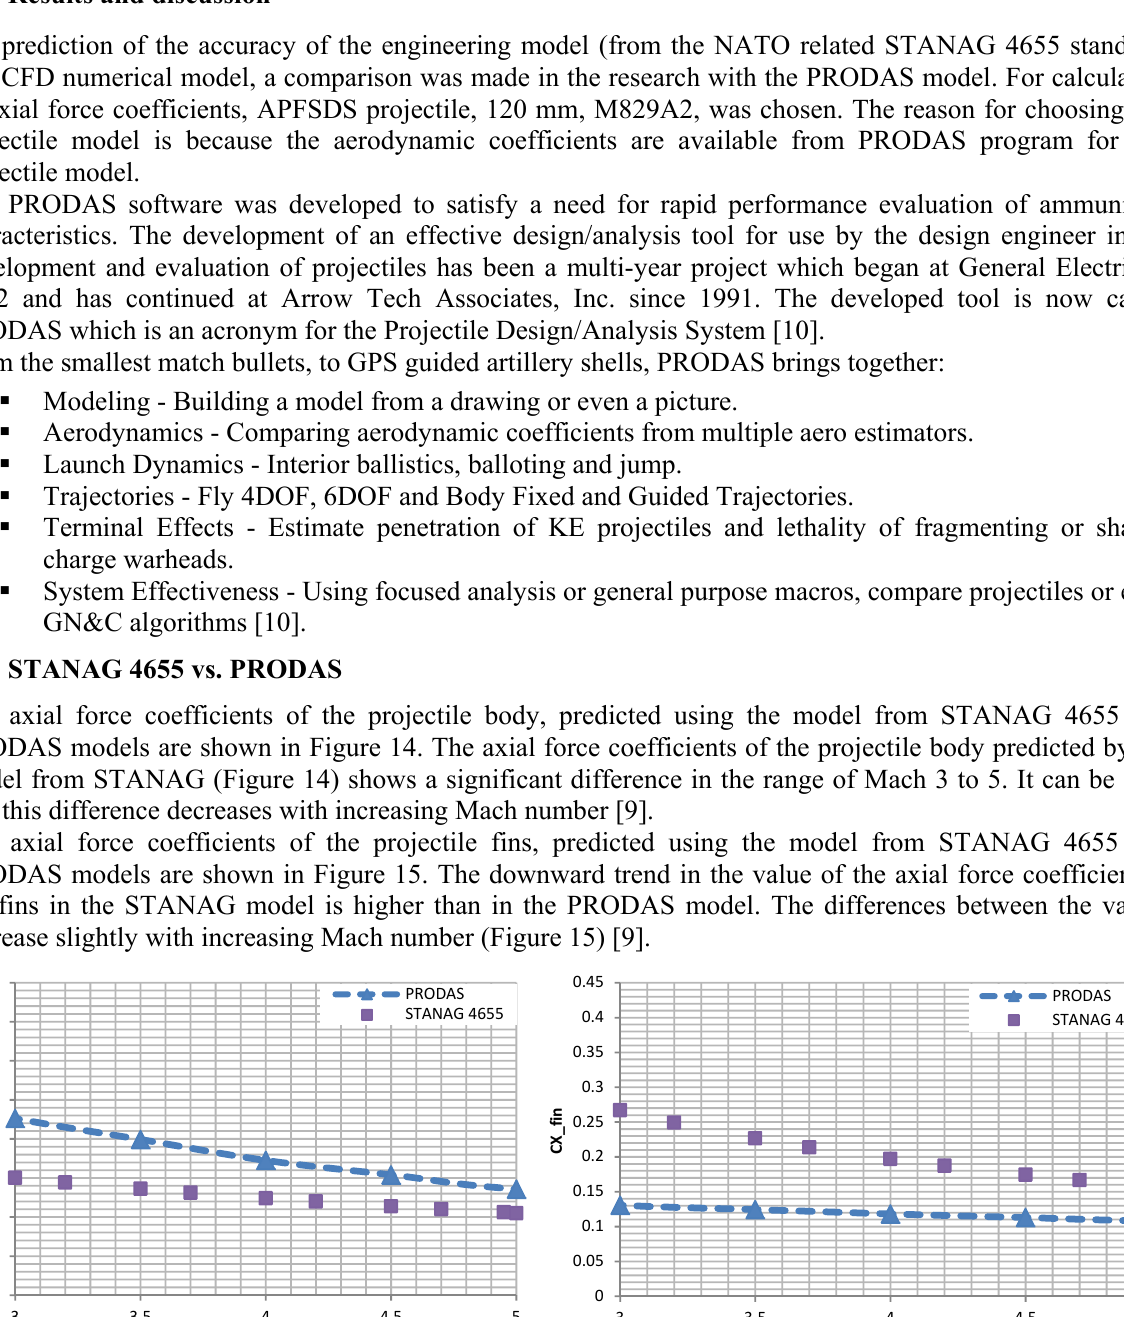
Figure 14. Coefficients of axial force of the projectile body (120 mm, M829A2) [9]